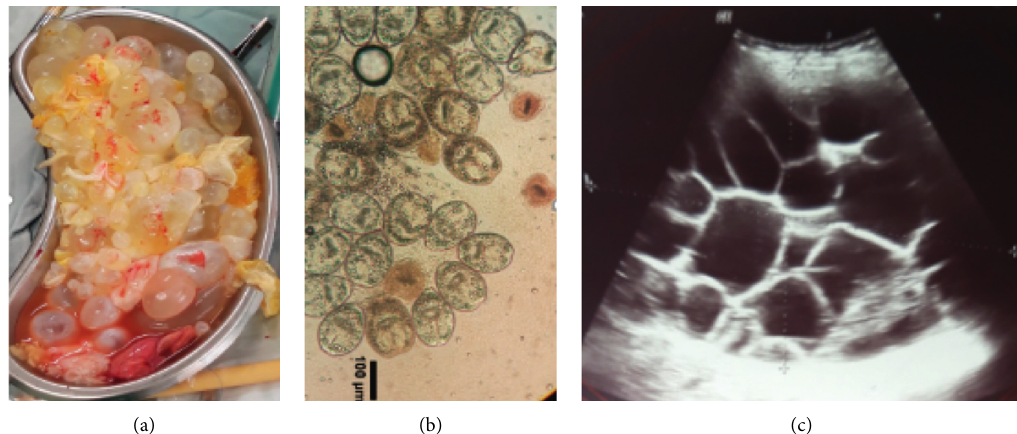
Figure 1: (a) Hundreds of daughter cysts removed from CE patient. (b) Using eosin 0.1% on the protoscoleces collected from cysts revealed more than 70% viability (viable protoscoleces do not stain by eosin). (c) Abdominal ultrasound showing a large multiloculated cyst on the liver which was classified as CE2 stage according to the WHO